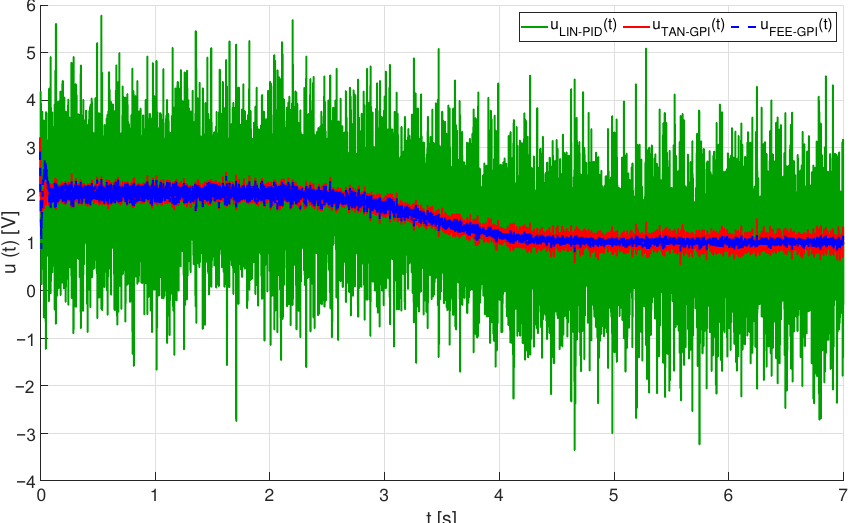
Figure 11. Control input of the magnetic levitation system, u ( t )[ V ] , with measurement noises and controller gain mismatches (Test